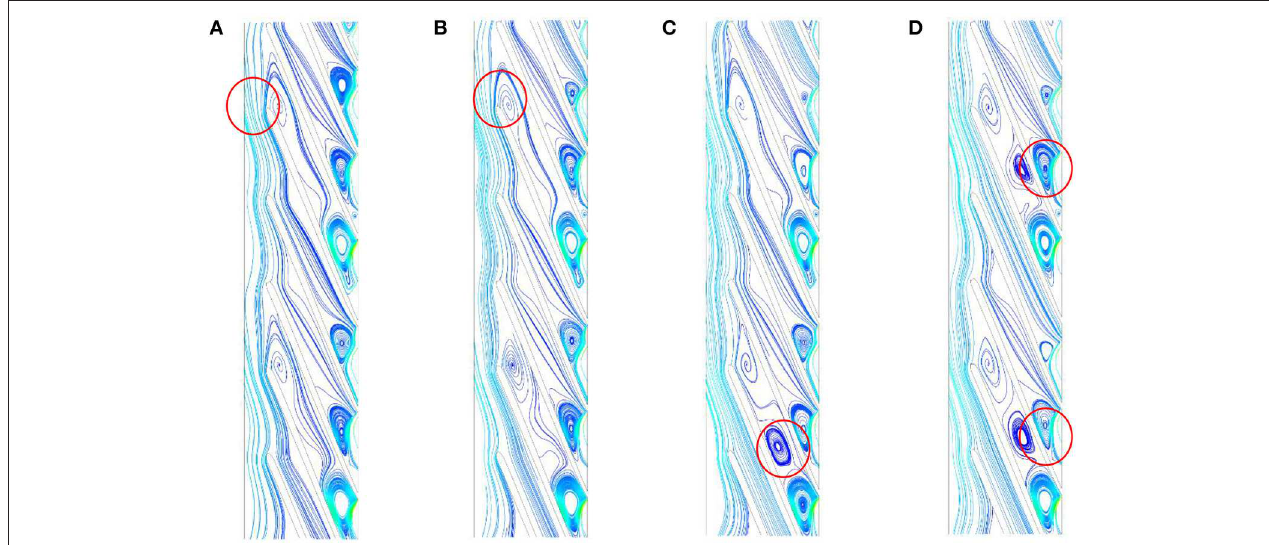
FIGURE 16 | Streamline distribution among blades with different flow rates in the start-up process of the open-valve transient. (A) Q = 8.01 m 3 /h, (B) Q = 11.39 m 3 /h, (C) Q = 17.48 m 3 /h, and (D) Q = 20.33 m 3 /h.